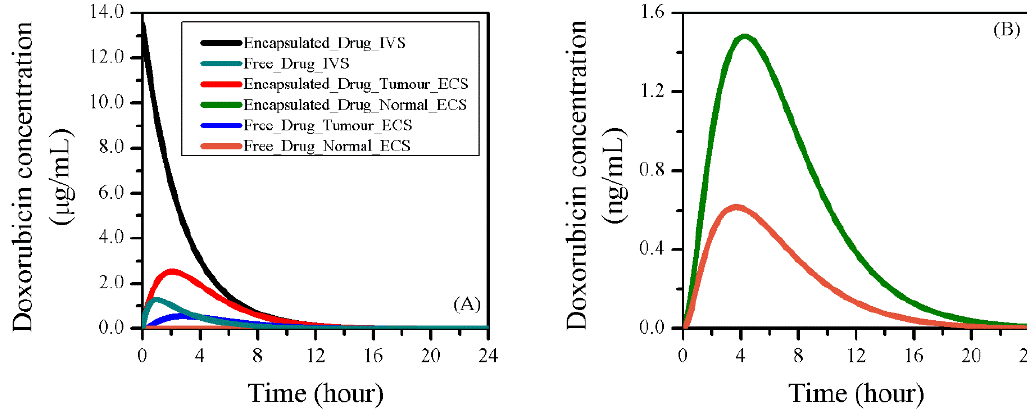
Figure 5. The concentration of doxorubicin in different forms in ( A ) each compartment of the brain tumour and the surrounding normal tissue. A close look in normal tissue is given in ( B ).